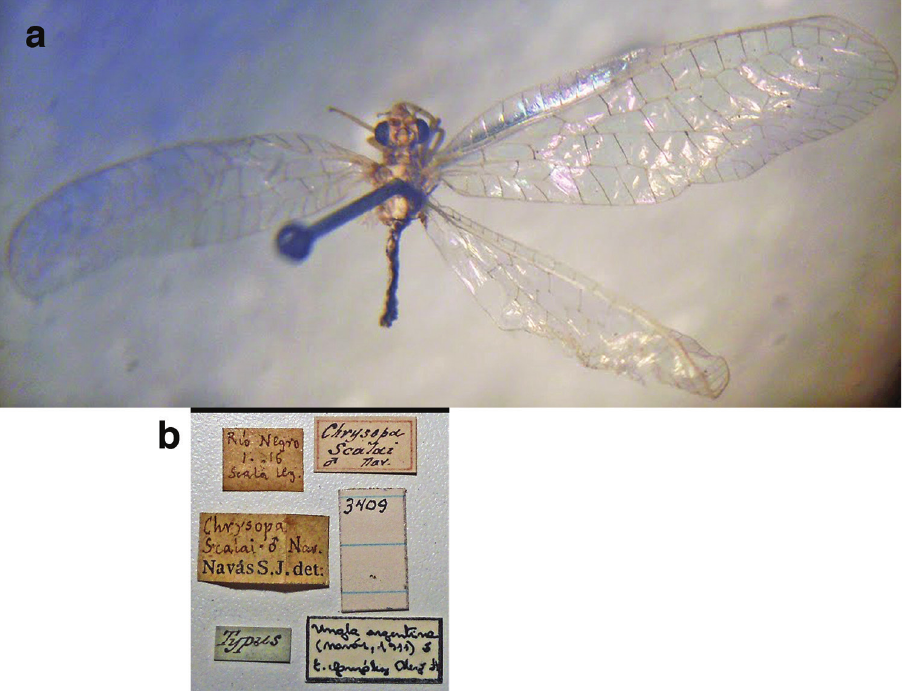
Figure 122. Chrysopa scalai Navás: Features, ( a ) habitus, dorsal ( b ) labels (Argentina, Rio Negro, lec- totype, male,